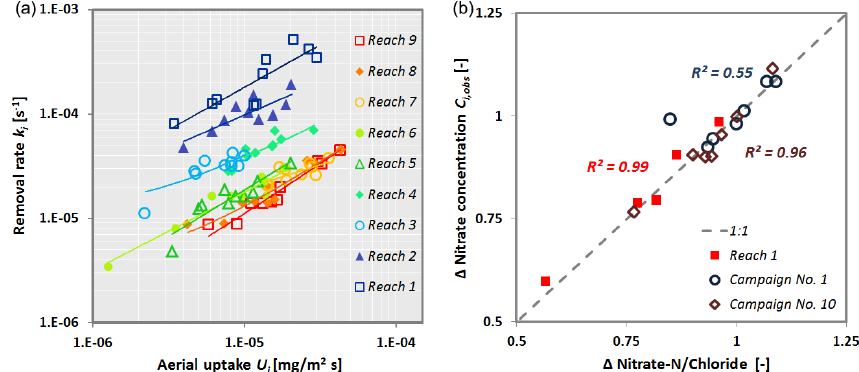
Figure 7. (a) Comparison of estimated in-stream nitrate removal rates k i ( s − 1) and areal nitrate uptake rates U i (mgm 2 s) per stream reach. (b) Comparison of observed relative changes in nitrate concentrations with observed relative changes in the ratio of nitrate/chloride per stream reach observed during the sampling campaigns No. 1 and No. 10 and during the additional sampling campaigns at Reach